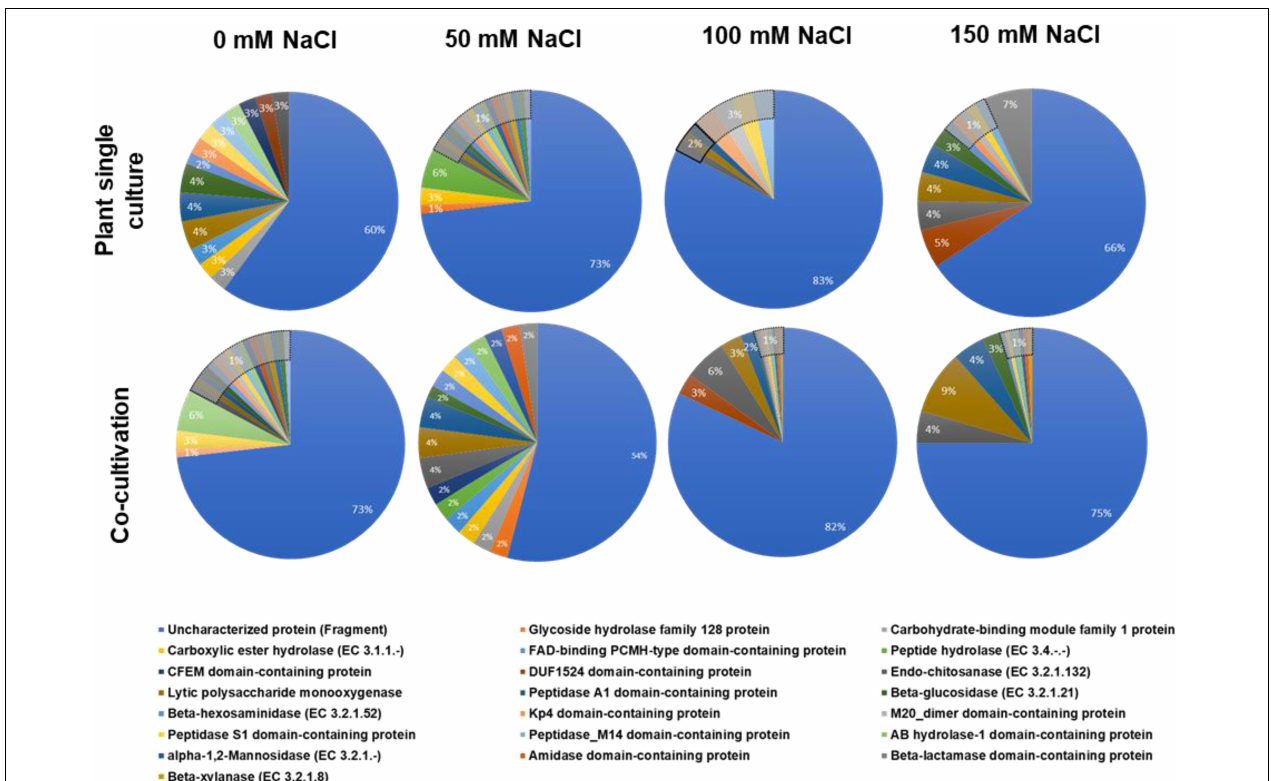
FIGURE 1 | Annotation of the identified fungal proteins according to the biological pathways (GO annotation). The fungus was either grown alone or in co-culture with the plants in media supplemented with 0, 50, 100, or 150 mM